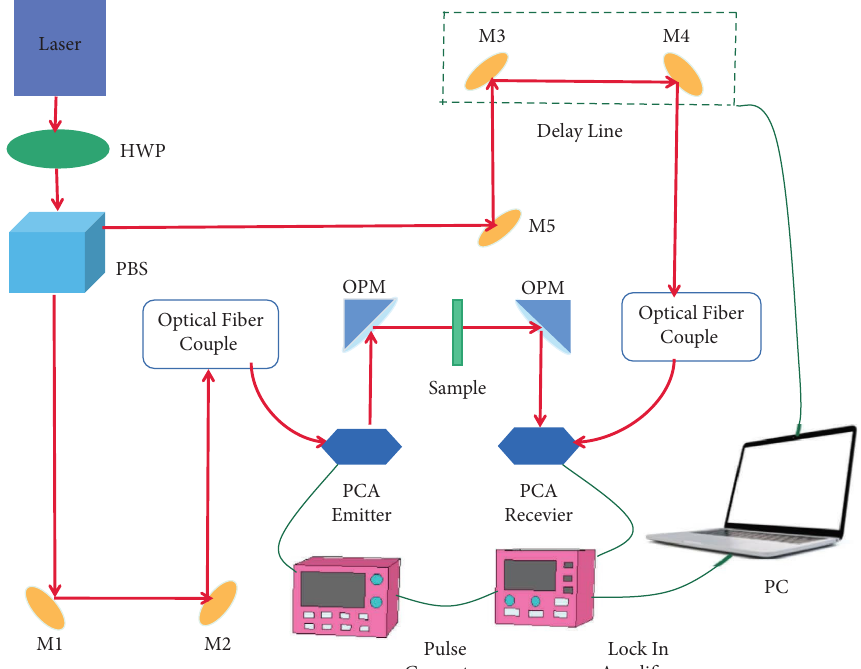
Figure 2: Experimental light path diagram. M1-5, refector; PBS, polarization beam splitter; HWP, half-wave plate; OPM, of-axis parabolic mirror.